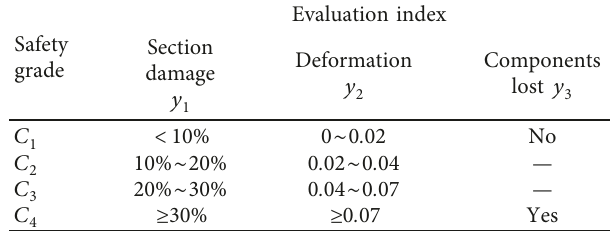
Table 5: Safety grade classification for Dougong.